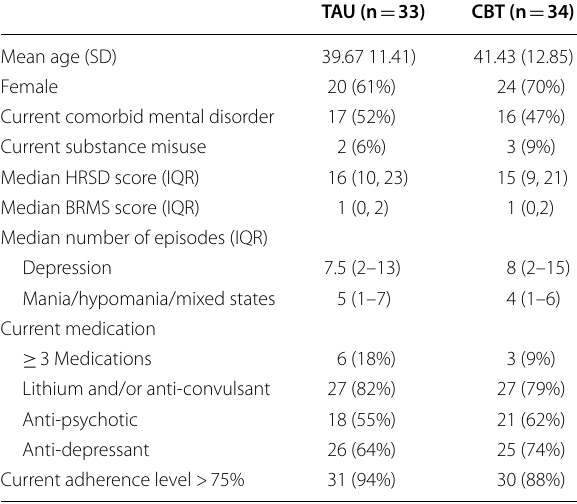
Table 1 Key characteristics of individuals with an index depressive episode